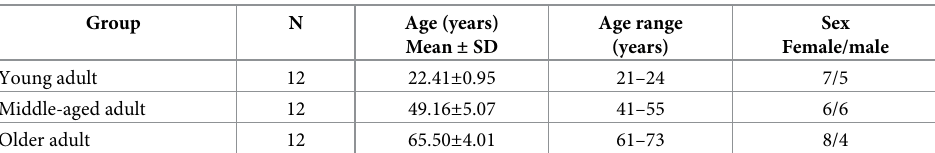
Table 1. Participant